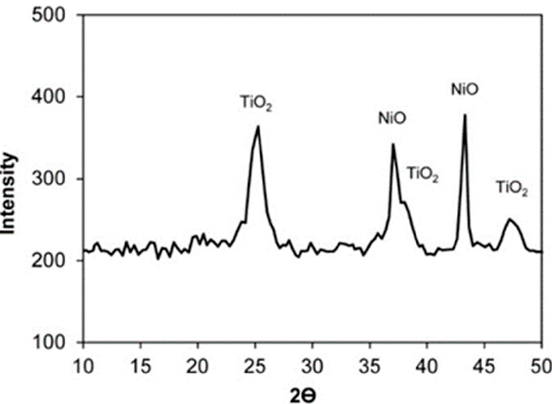
Figure 3. The XRD pattern of the 16%Ni/20%WO 3 –TiO 2 catalyst. The size of NiO nanoparticles is 40 nm, the size of the TiO 2 nanoparticles is 18 nm.